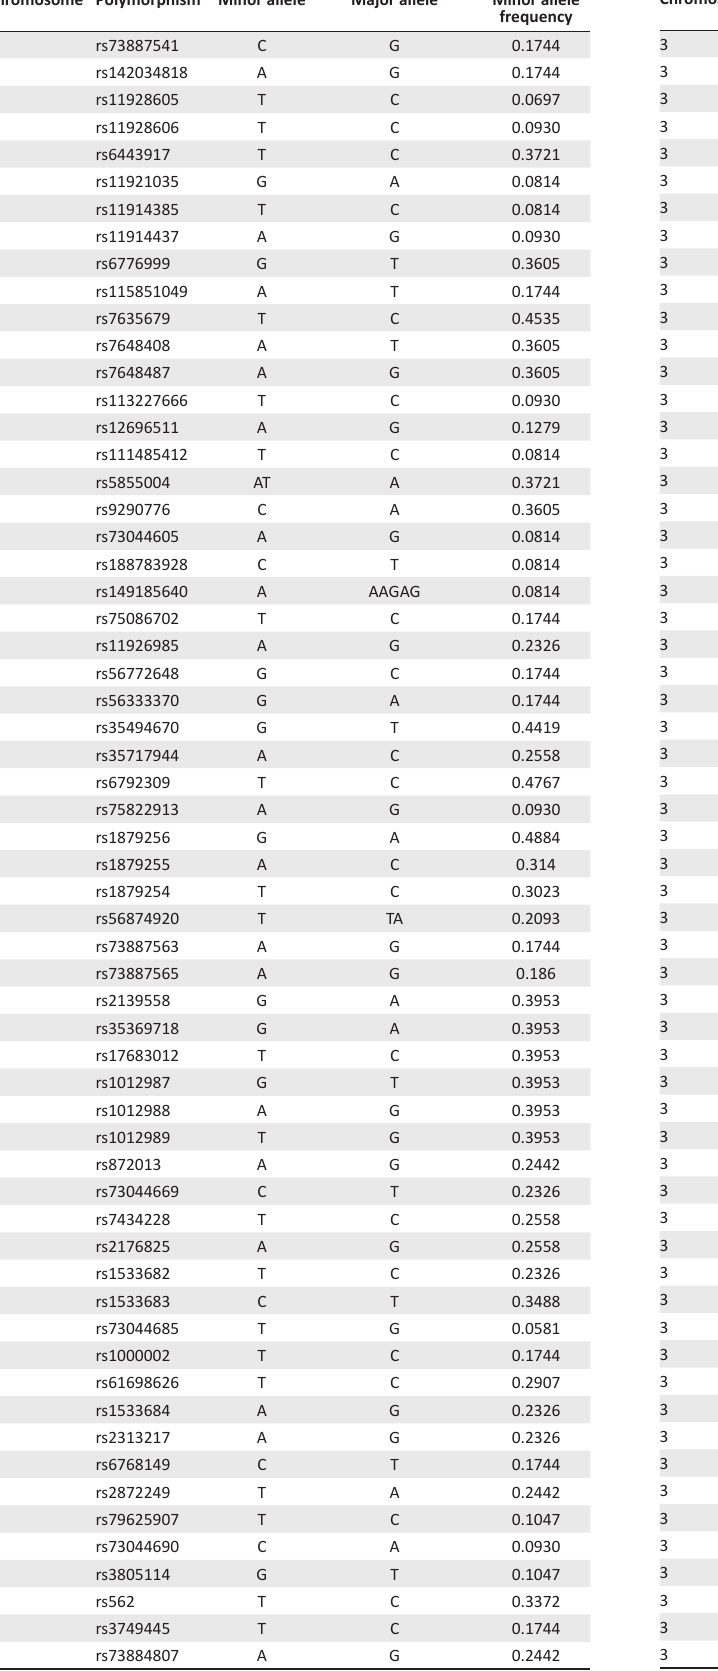
Table 1-A1 (Continues...): Minor allele frequencies for 1846 polymorphisms in 43 black South Africans. Chromosome Polymorphism Minor allele Major allele